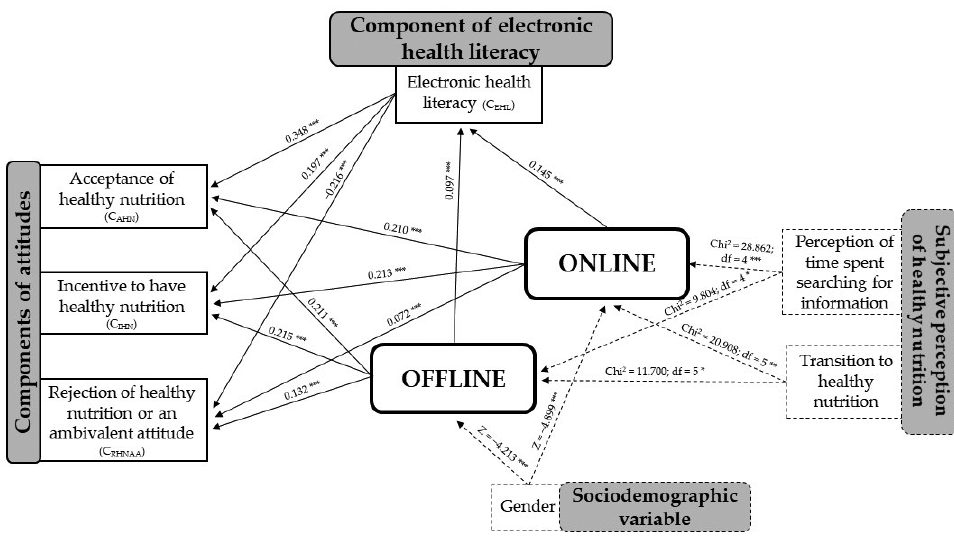
Figure 5. Theoretical concept of the relationship between online and offline information-seeking attitudes related to healthy nutrition. Correlation coefficient (r) values. Significance: * p ≤ 0.05; ** p < 0.01; *** p < 0.001.